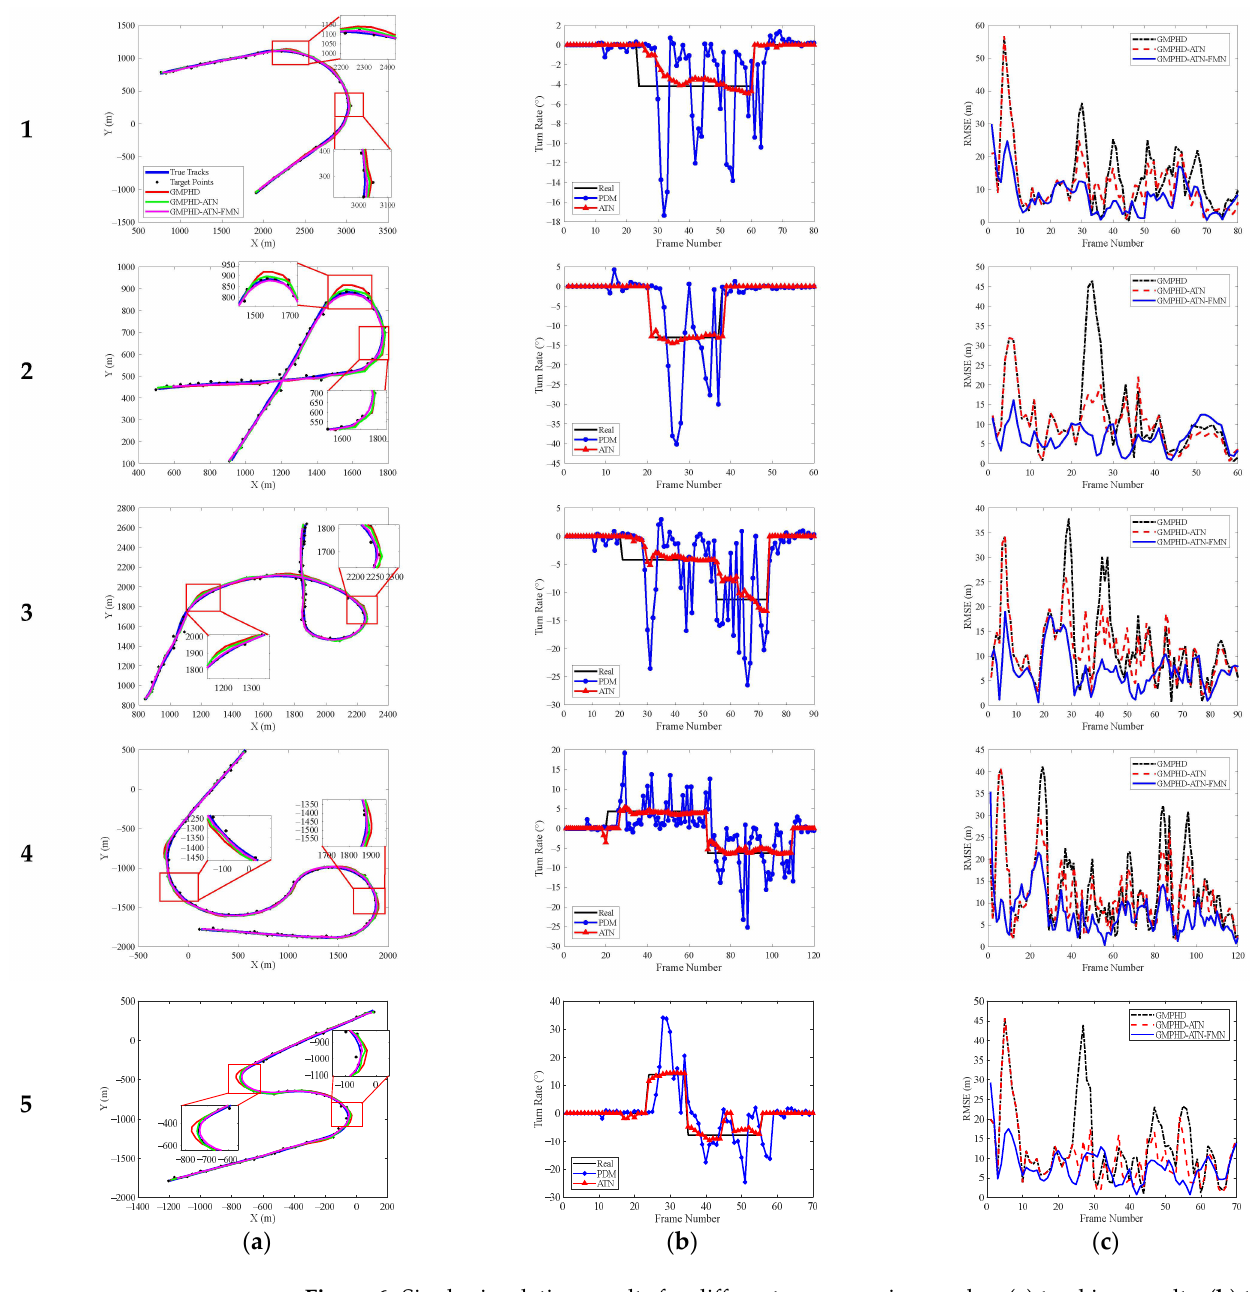
Figure 6. Single simulation results for different maneuvering modes: ( a ) tracking results, ( b ) turn rate estimates, and ( c ) tracking errors.